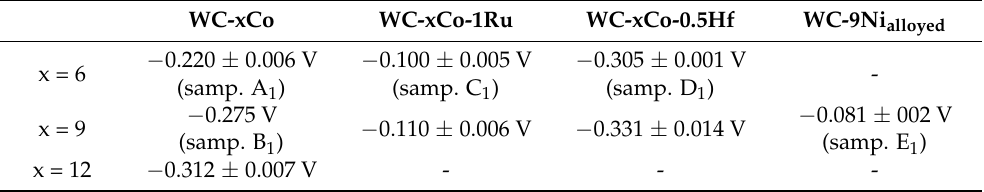
Figure 9. ( A – E ) LSV curves measured in tap water (black plots) and NaCl 0.6 M (red plots) of the grades listed in Table 1. Scan rate: 1 mV s −1 . ( F ) Open circuit potential (OCP) values measured in tap water. Table 5. Open circuit potential values of different CC grades in 0.5 M Na 2 SO 4